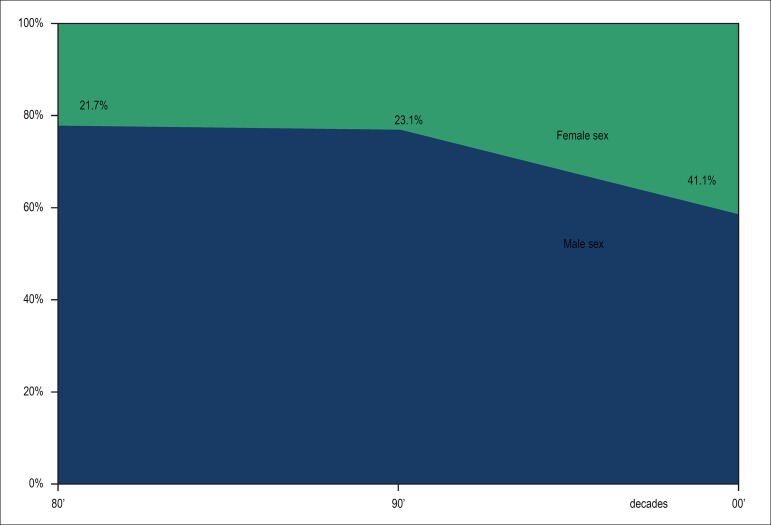
Gender distribution of the postgraduate students.